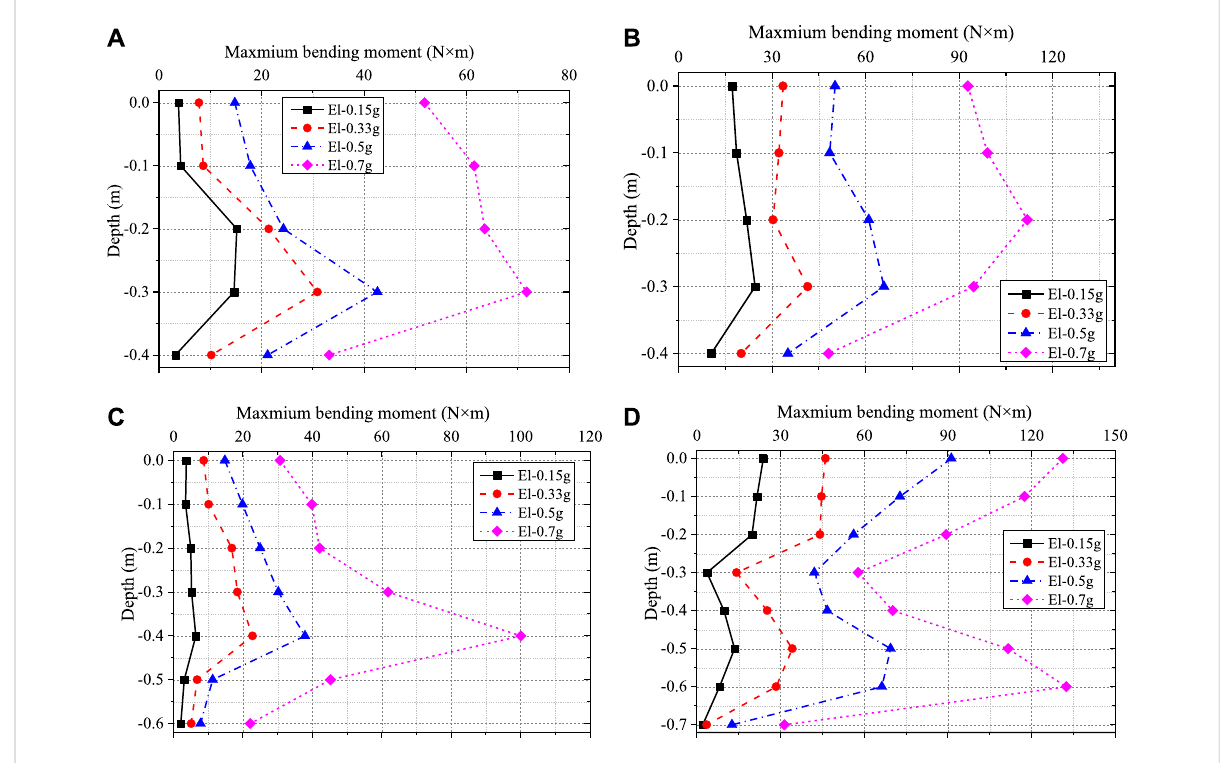
FIGURE 12 Maximum bendingmomentofthepilesunderdisposalcontainers: (A) 3#-P1; (B) 3#-P2; (C) 5#-P1; (D) 5#-P2 withsaturatedmoisturecontent.